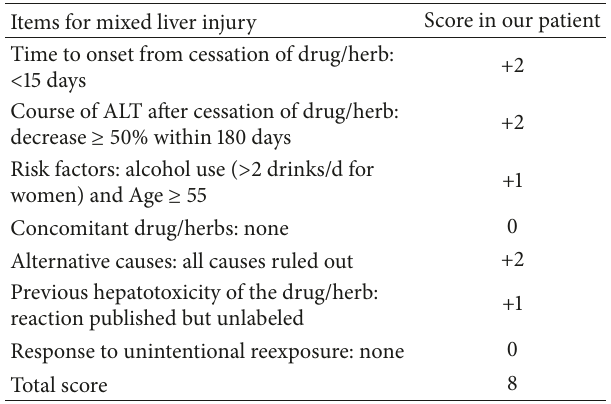
Table2:RousselUclafCausalityAssessmentMethod,anassessment of the causality of drug-induced liver injury.